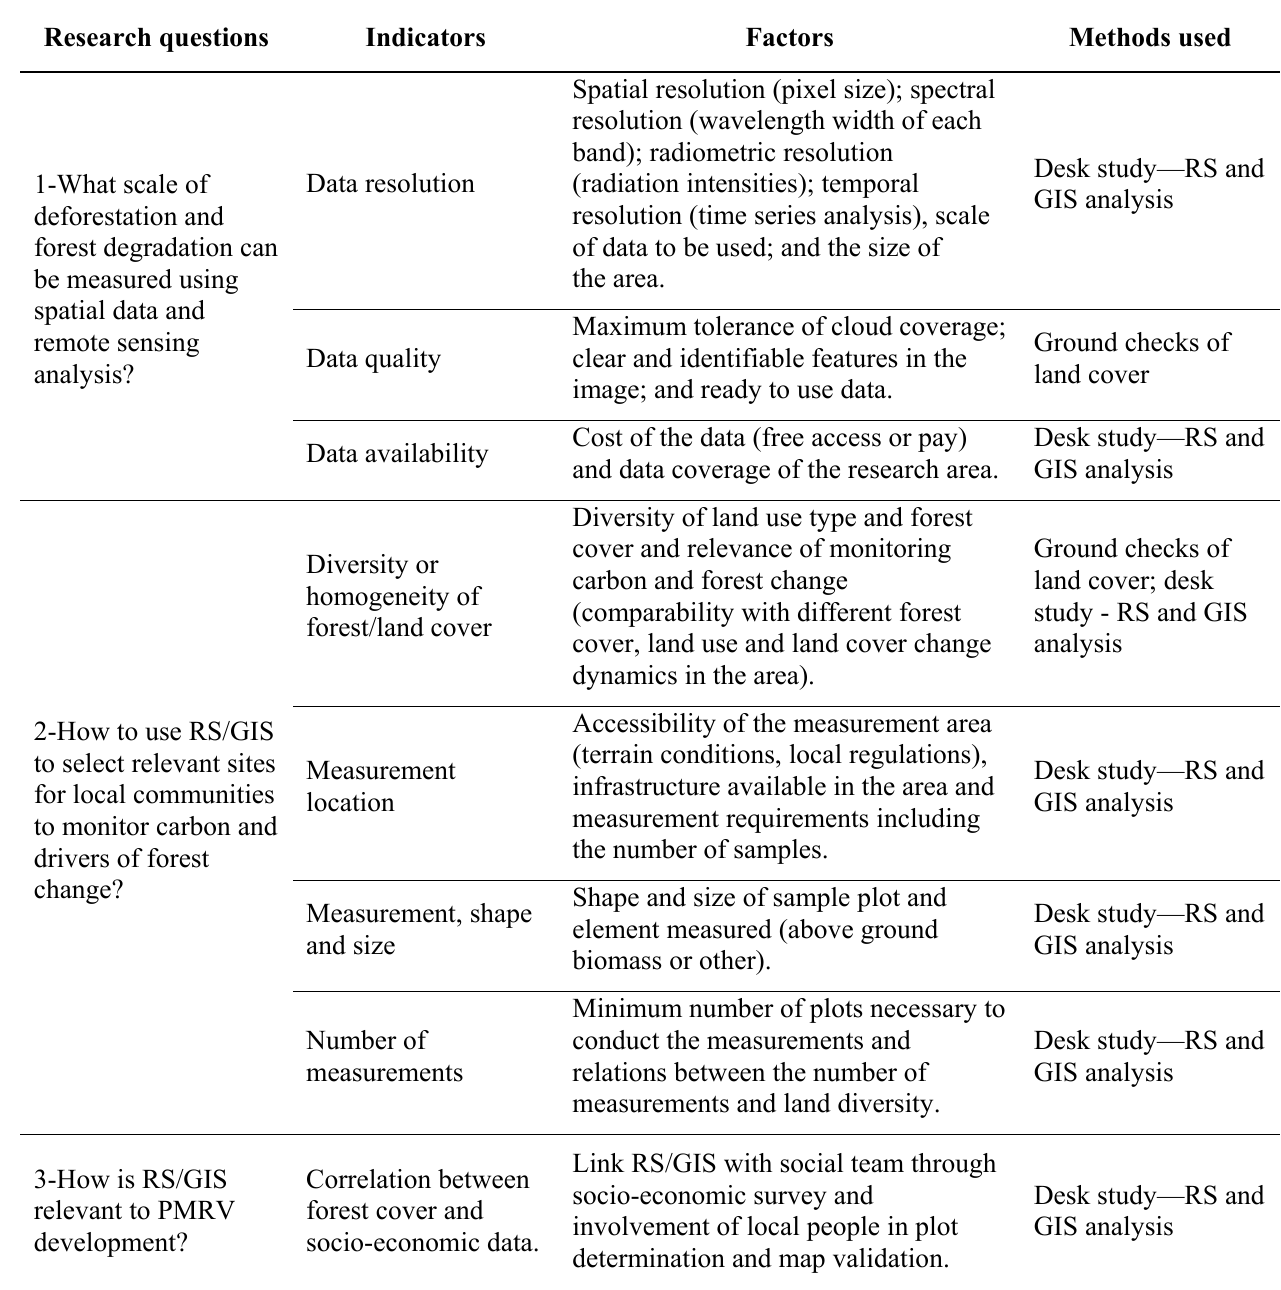
Table 5. Research design for verification of local measurements using remote sensing and geographical information